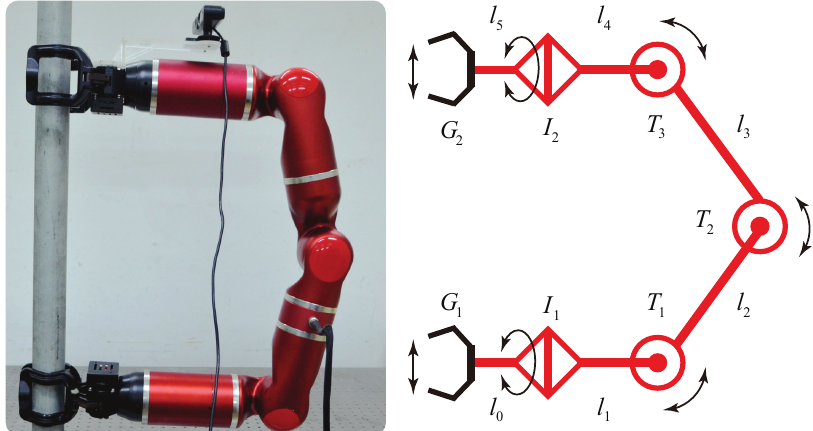
Figure 1. The 5-DoF Climbot and its kinematic